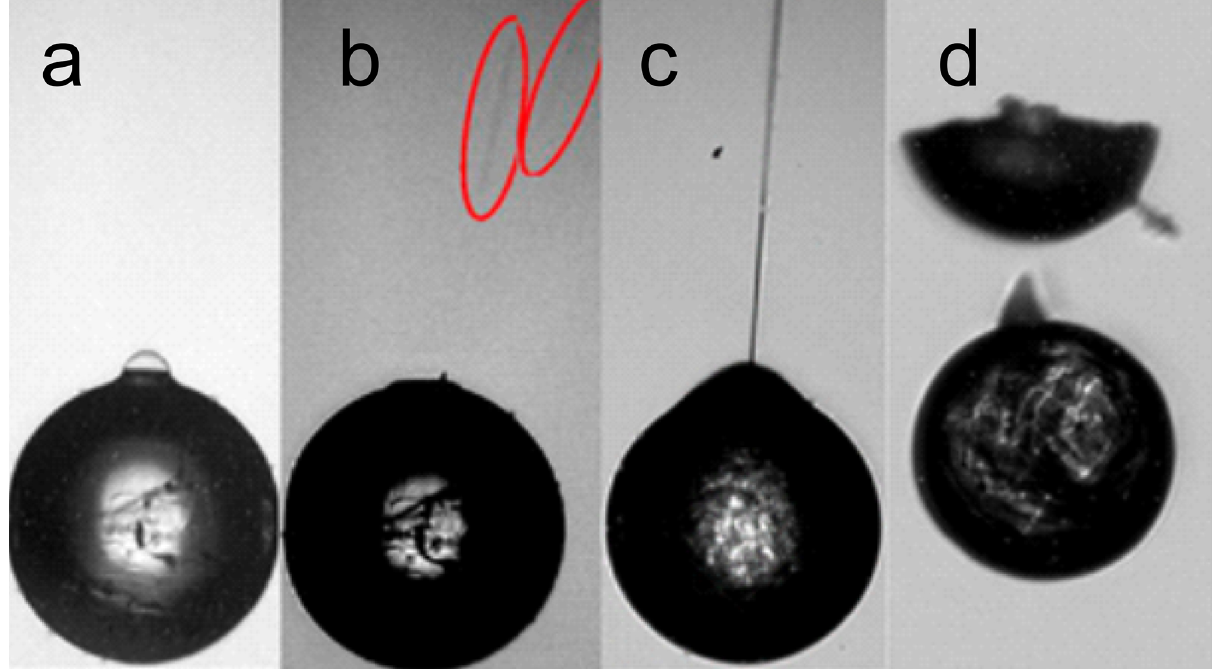
Figure 8. Secondary ice processes. (a) As observed by high-speed microscopy a bubble has formed on the surface of a freezing droplet. Cracks are visible in the surface. (b) The droplet from (a) but 12ms later: the bubble has burst; two fragments are highlighted by red ellipses. (c) Jetting: a jet of liquid water is expelled violently through a hole in the ice shell. (d) Breakup: a freezing droplet splits in two halves; a few small fragments are sometimes observed (adapted from Lauber et al.,